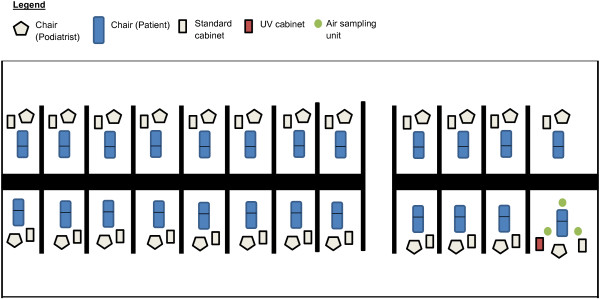
Schematic of the podiatry clinic sampled in the investigation. (Not to scale).